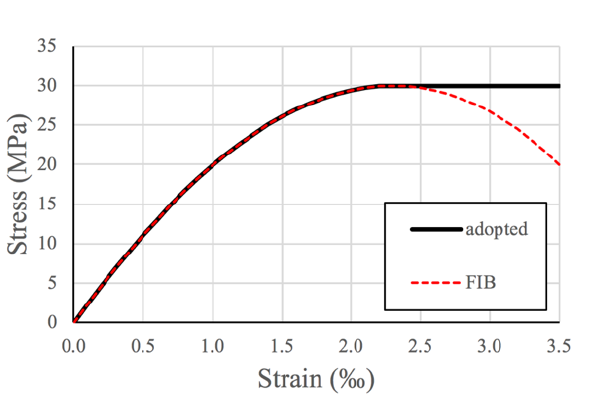
Figure 7. Stress-strain graph of compressed concrete